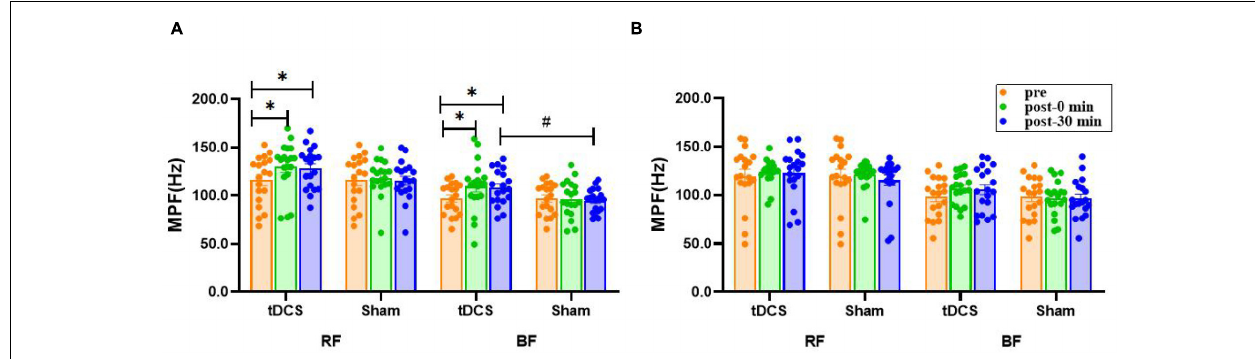
FIGURE 6 | Effects of tDCS on MPF (Hz) of left (A) and right (B) rectus femoris and biceps femoris sEMG. pre: prestimulation, post-0 min: 0 min after stimulation, post-30 min: 30 min after stimulation; RF: rectus femoris, BF: biceps femoris. Data are presented as mean ± SEM. Asterisks ( ∗ ) indicate statistically significant difference compared to prestimulation ( ∗ P < 0.05). Well number (#) indicates statistically significant difference compared to sham ( # P <